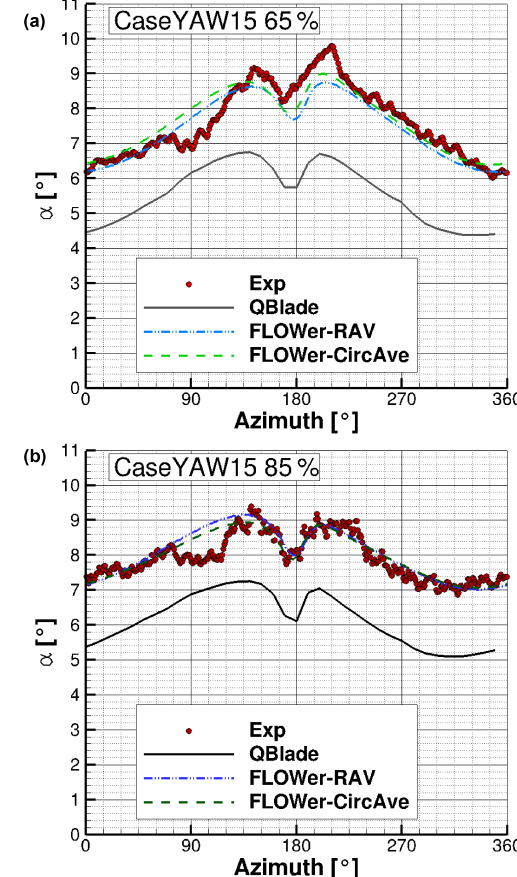
Figure 17. AoA distribution over the azimuth for CaseYAW15 for the experiment, QBlade and FLOWer (RAV and CircAve) at 65% R (a) and 85% R (b) .